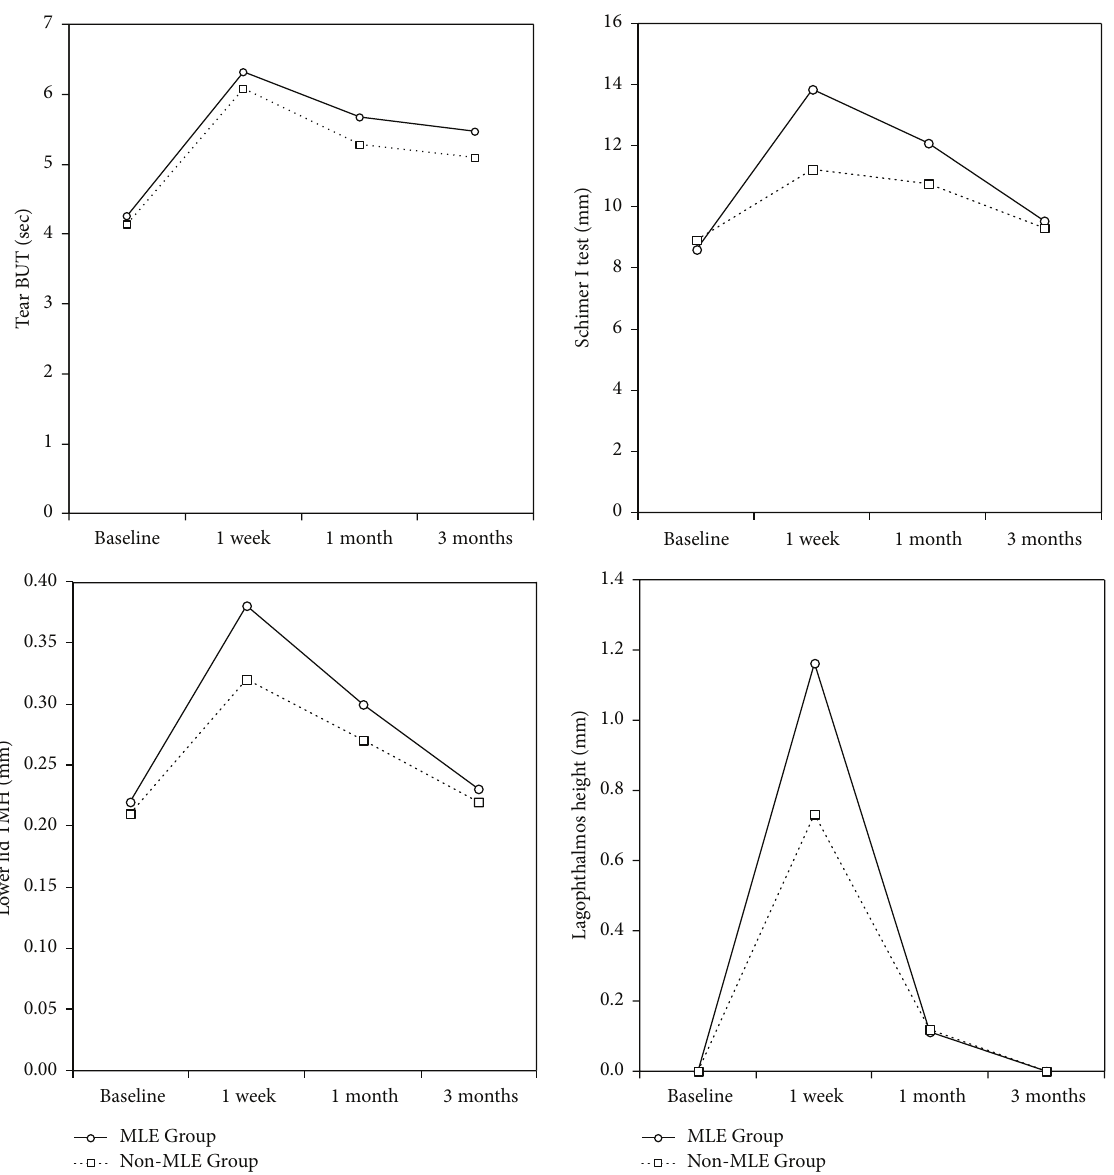
Figure 2: Changes in objective parameters of the MLE Group and the non-MLE Group before and after BoNT-A injection.